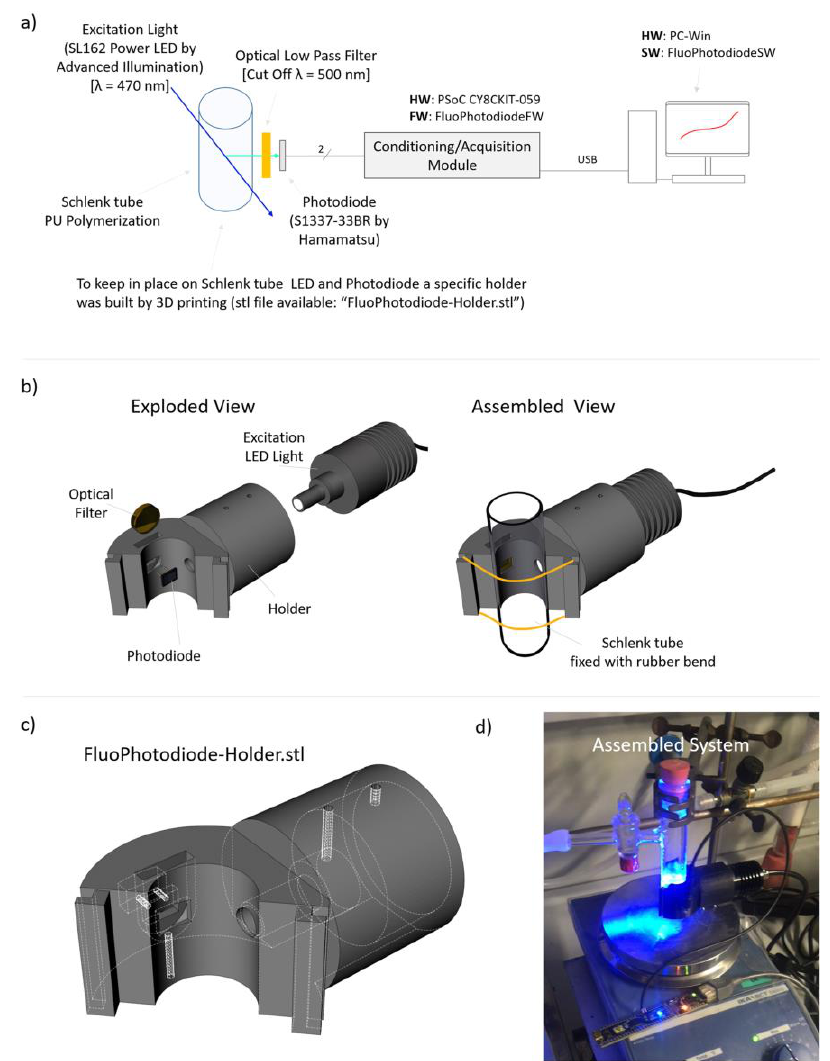
Figure 4. Details of the led/photodiode set-up system design. ( a ) Overall LED/photodiode system schematic; ( b ) LED/photodiode system: exploded view (l eft ) and assembled view ( right ); ( d ) LED/photodiode holder CAD design; ( d ) picture of the working assembled system. All the information, electronic and mechanical schemes, firmware, and software code are available as an open-source resource at: https://doi.org/10.5281/zenodo.4362276.